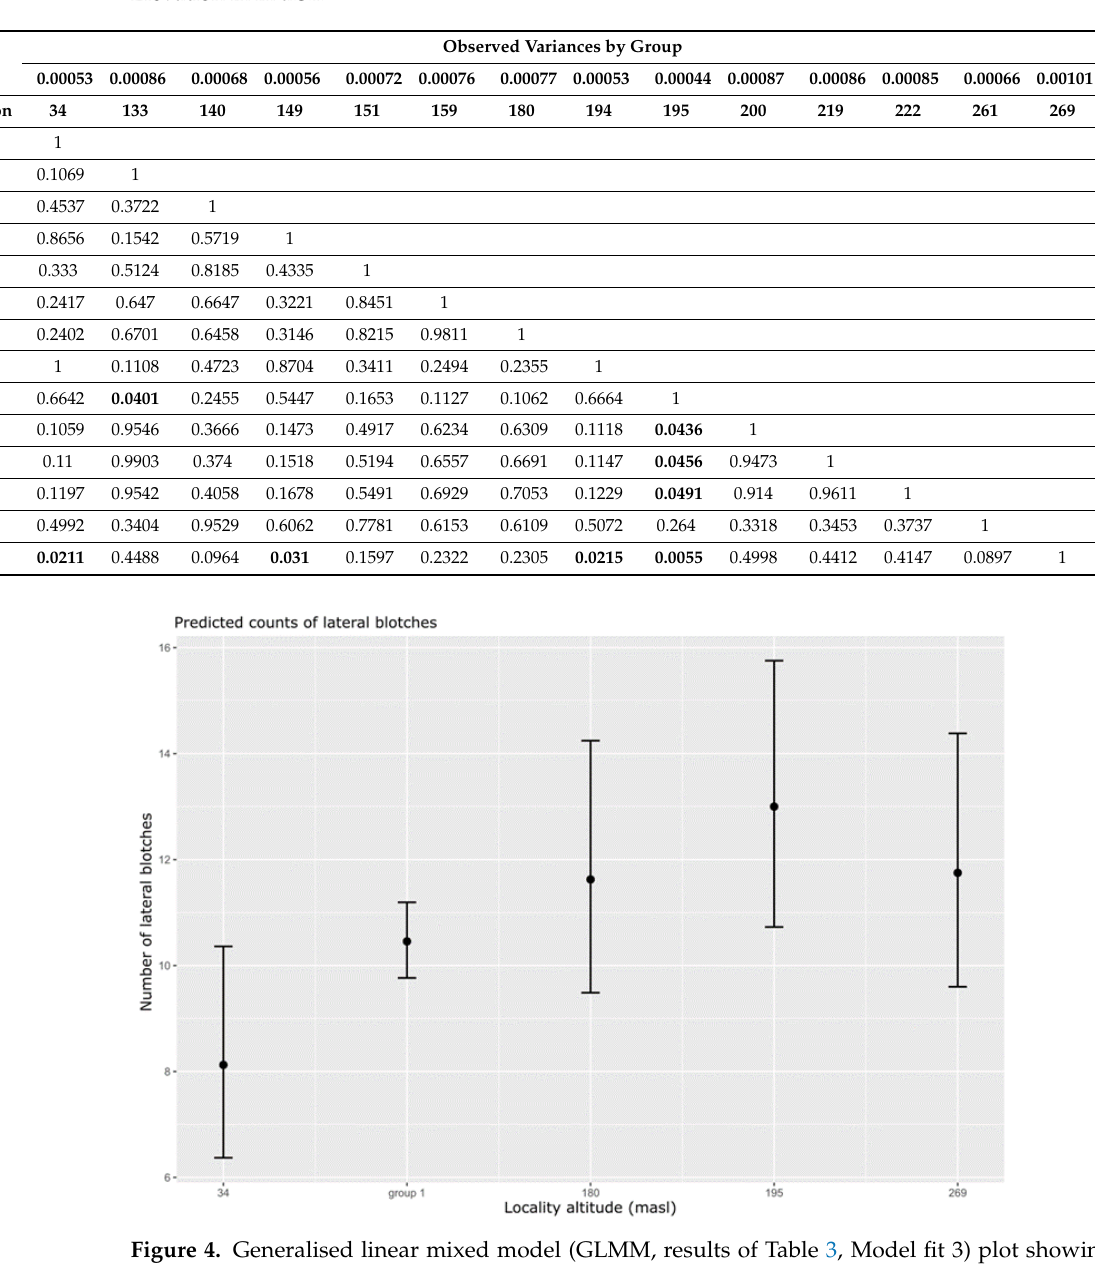
Table 2. Morphometric variance of 111 individuals of Sabanejewia spp. within the groups and pairwise comparisons of group variances (two ways) based on elevation of the localities listed in Table S1. Elevation in m a.s.l.